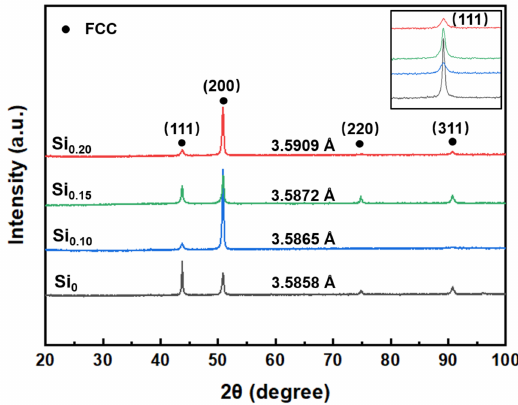
Figure 1. XRD patterns of the as-cast Si x MEAs.